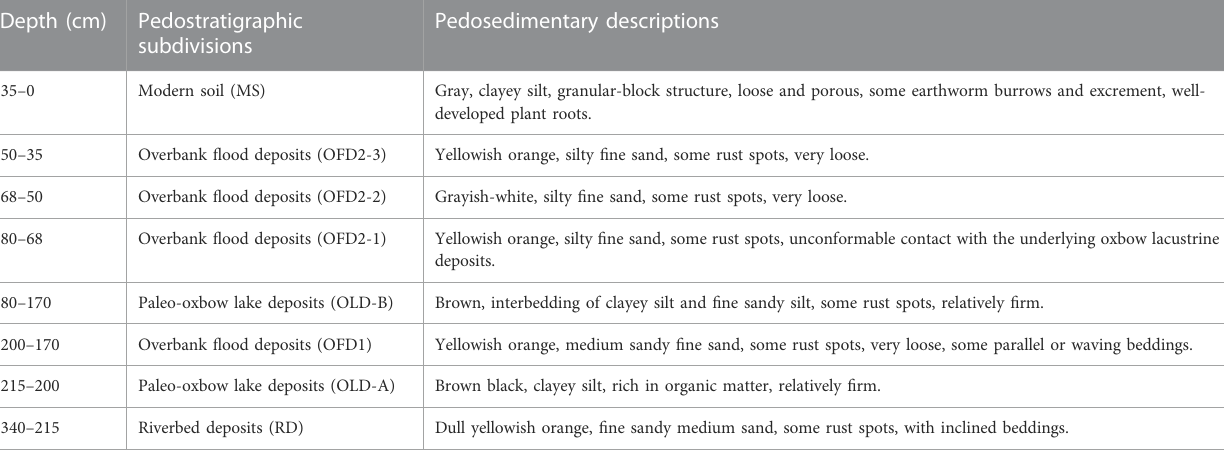
TABLE 1 Pedosedimentary descriptions of the paleo-oxbow lake fi ll at NYQ-B site within the Zoige Basin on the NE Tibetan Plateau.